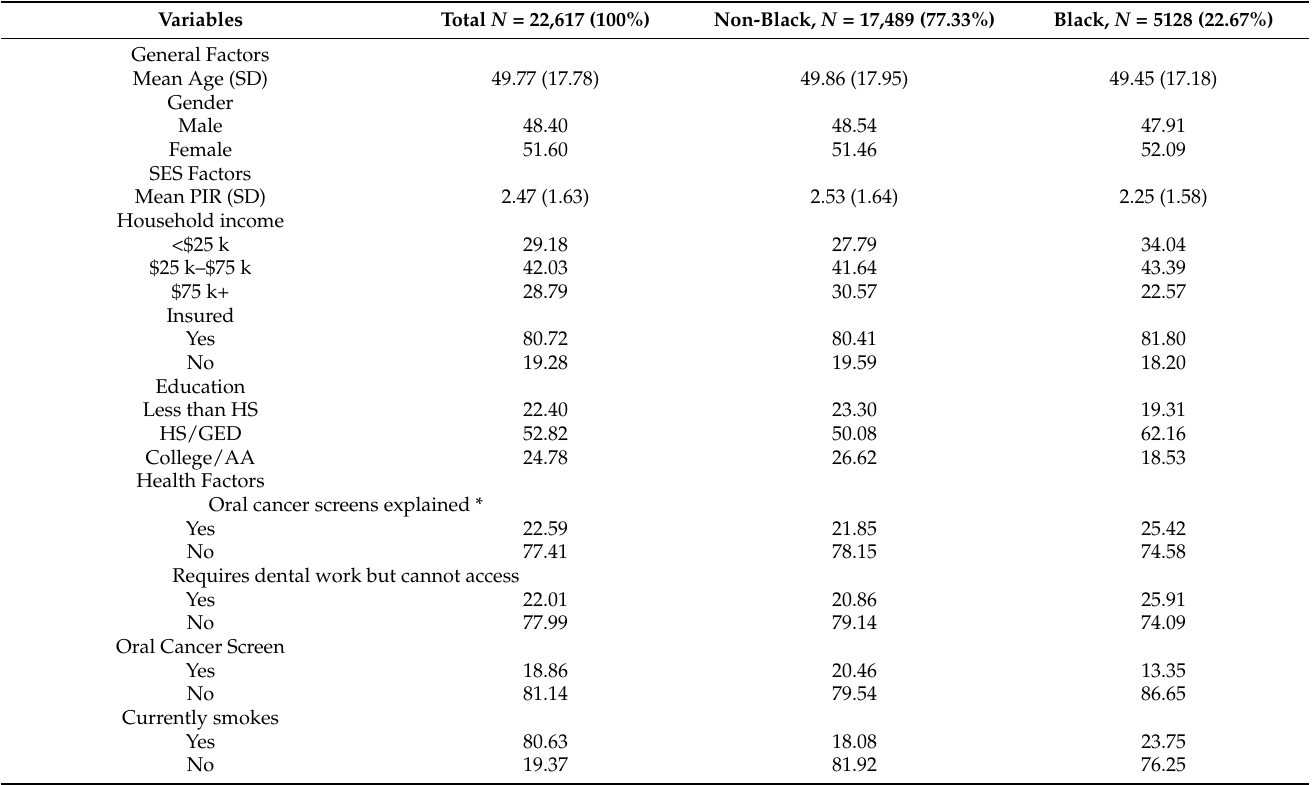
Table 1. Descriptive statistics of cohort by non-Black and